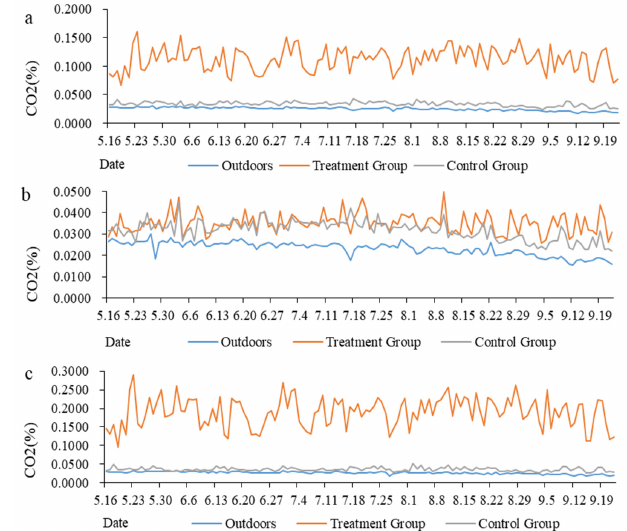
Figure 1. The variation trends in CO 2 concentration throughout the experimental period. a: The variation trends in CO 2 concentration all day. b: The variation trends in CO 2 concentration during the light period (9:30~16:30). c: The variation trends in CO 2 concentration during the dark period (16:30~9:30 next day).